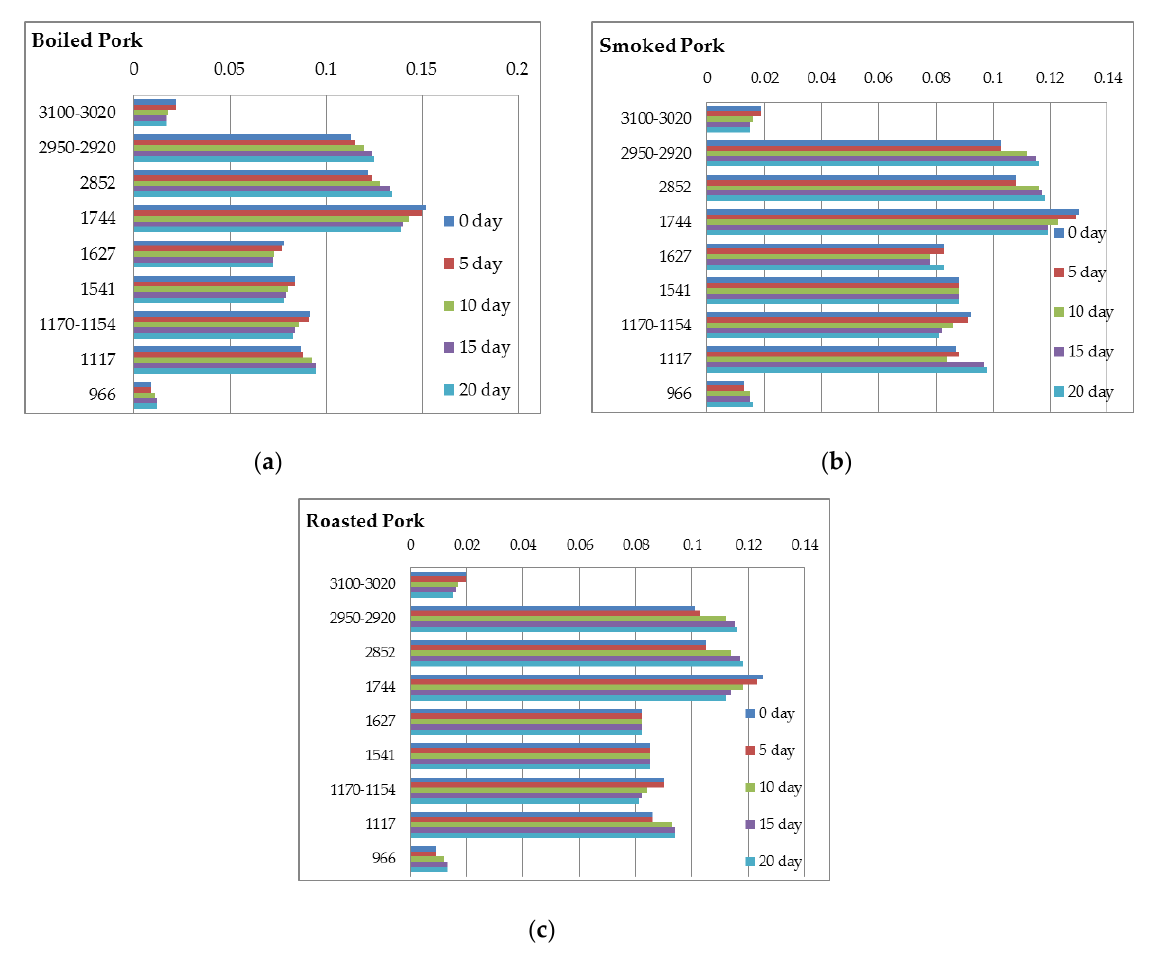
Figure 6. Spectral absorbance bands (intensities) (X-axis) at characteristic regions (cm -1 ) (Y-axis) during storage in refrigeration for twenty days: (a) boiled-pork hams; (b) smoked-pork hams; (c) roasted-pork hams.